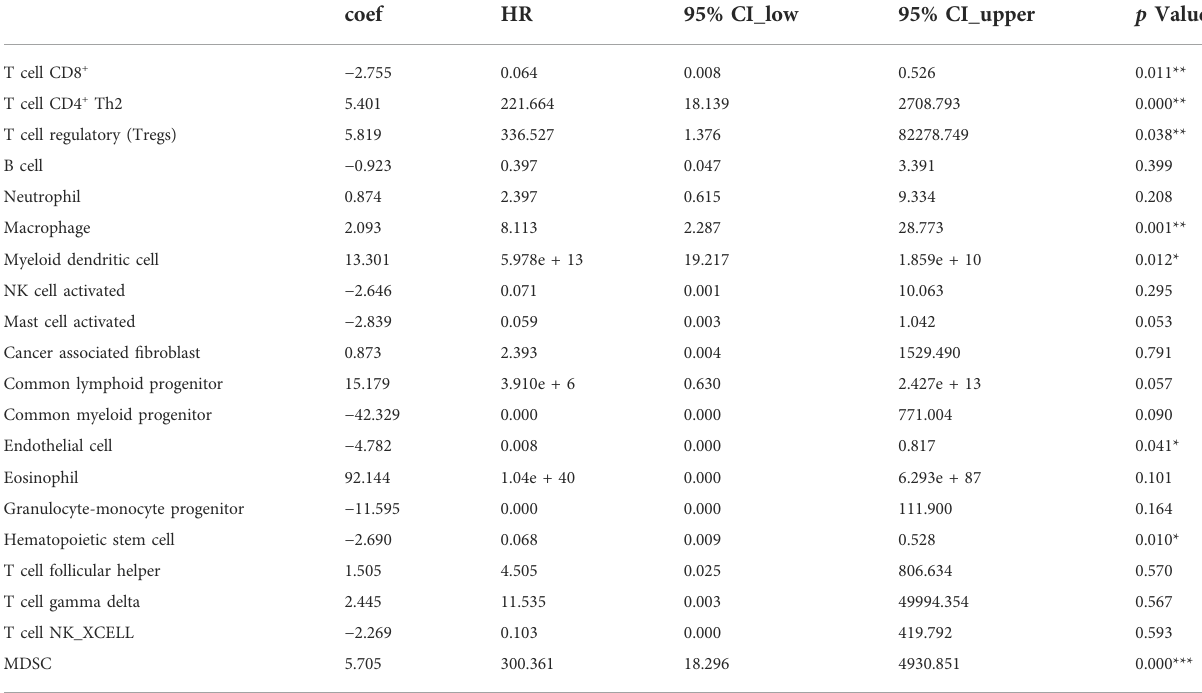
TABLE 2 The associations analyzing by Multivariate Cox proportional hazards regression models between immune in fi ltrates and overall survival of LIHC in TCGA ( n = 371). coef HR 95% CI_low 95% CI_upper